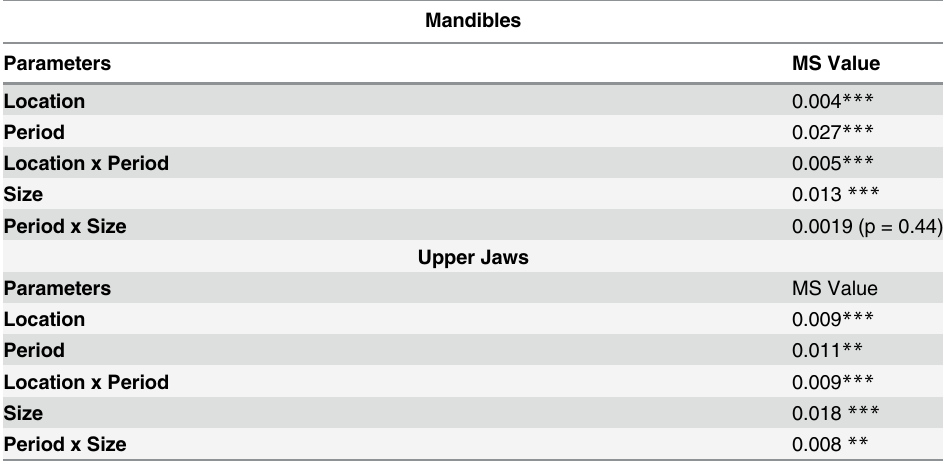
Table 4. Summary of predictors of jaw morphology.